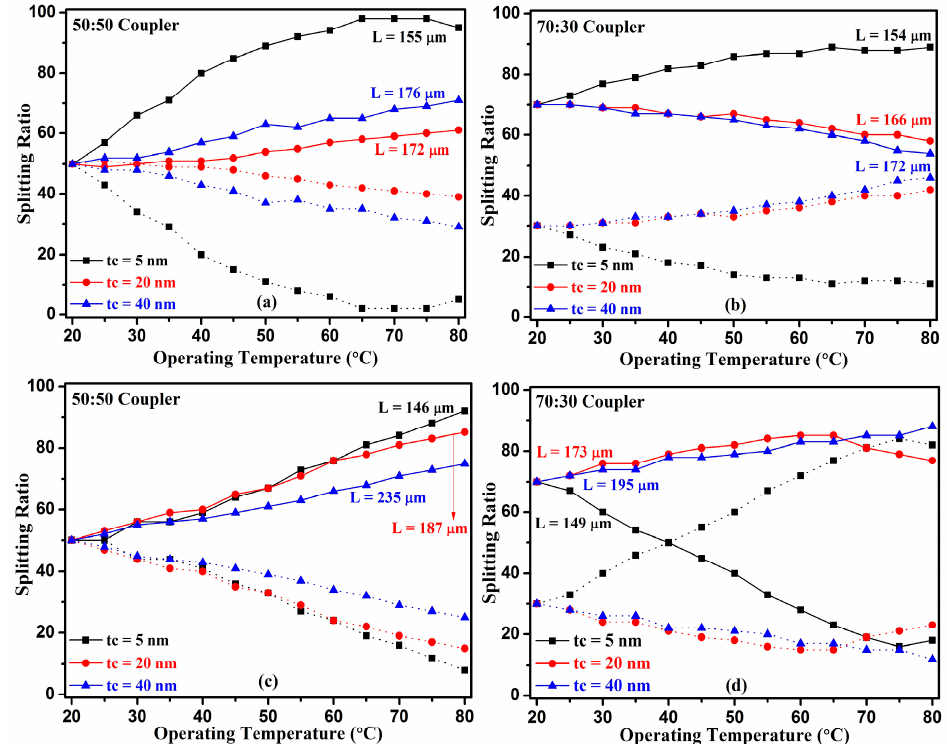
Figure 2. Impact of operating temperature on power splitting ratio on rectangular and trapezoidal waveguides. Shown are ( a ) 50:50, ( b ) 70:30 splitting ratio variation for rectangular ( θ = 90 ◦ ) and ( c ) 50:50, ( d ) 70:30 for trapezoidal ( θ = 110 ◦ ) ridge waveguides in the absence of stress. L is the coupling length at which the specific splitting ratio can be acheived for particular SiGe cladding thickness. Power splitting ratios at bar port and cross port are shown by solid and dashed lines, respectively.